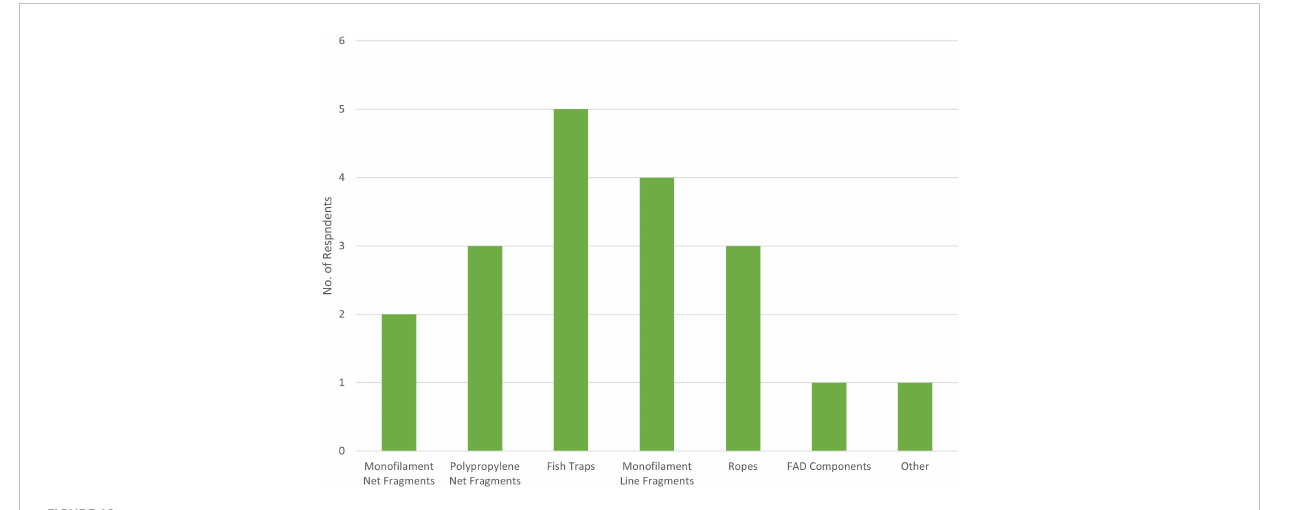
FIGURE 12 Components of ALDFG encountered by divers in Dominica (n =